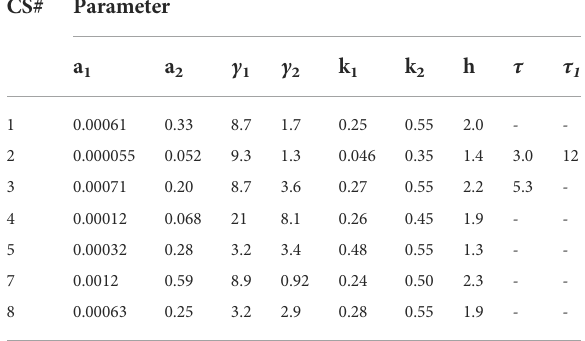
all three cases with glucose dependent glucagon suppression constant decreasing with increasing A1c, FG and 2 h PG. Two